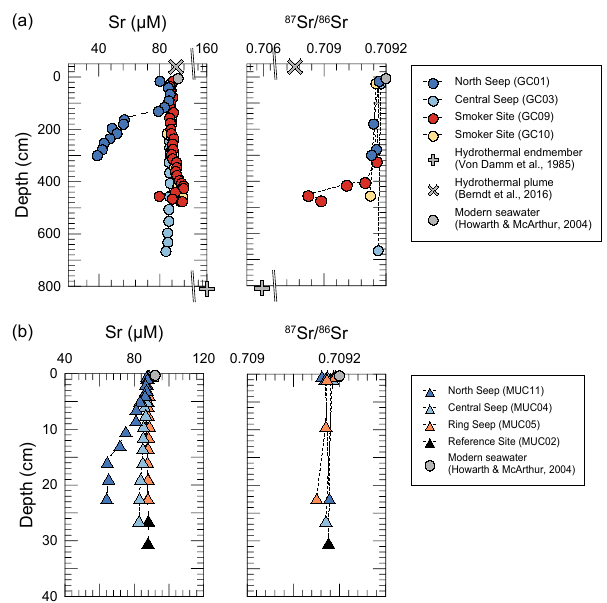
Figure 5. Sr concentrations and 87 Sr / 86 Sr ratios for GCs (a) and MUCs (b) . For comparison, data from the hydrothermal plume (Berndt et al., 2016), the hydrothermal endmember (Von Damm et al., 1985), and modern seawater (Howarth and McArthur, 2004) are shown. Note the different x -axis scales for MUC Sr concentration and 87 Sr / 86 Sr